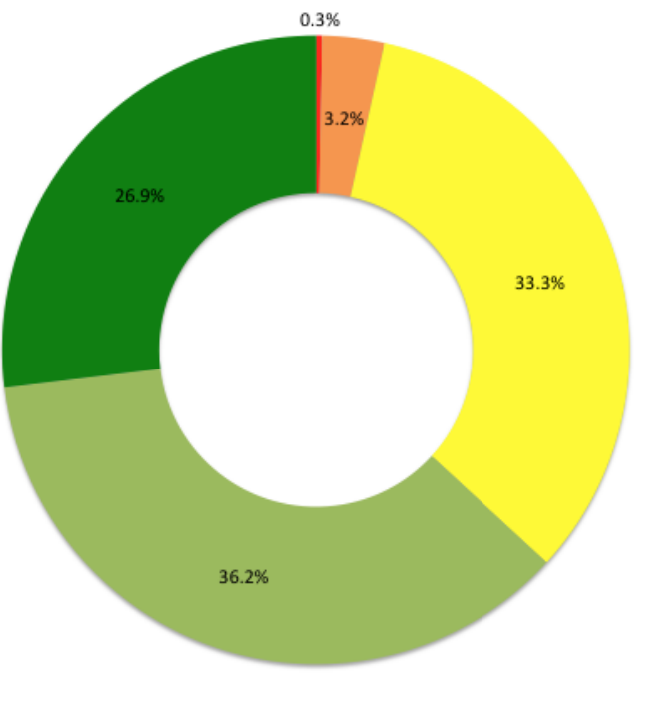
Figure 4. Respondents’ perceptions of quality of their open